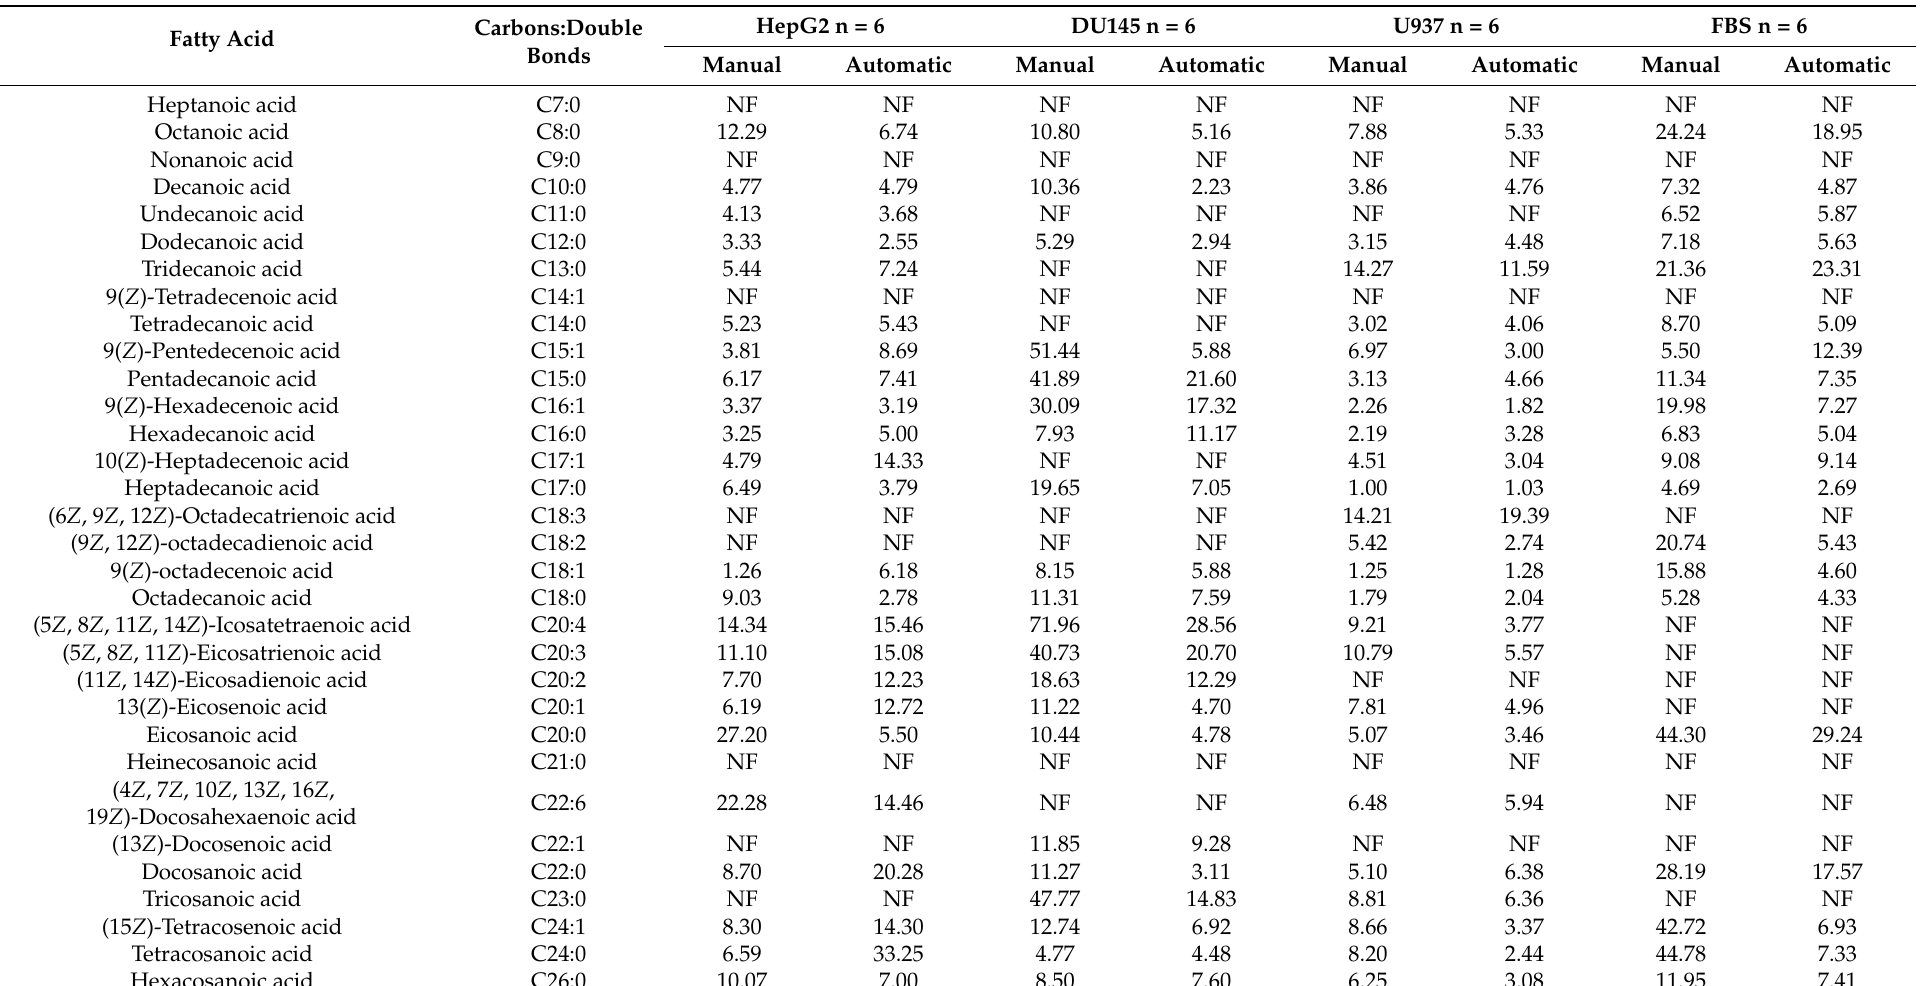
Table 2. Compiled relative standard deviations of analyzed free fatty acids in biological matrices after manual and automated TMSH derivatization. Improvements in reproducibility are indicated with bolded %RSD values. NF = not